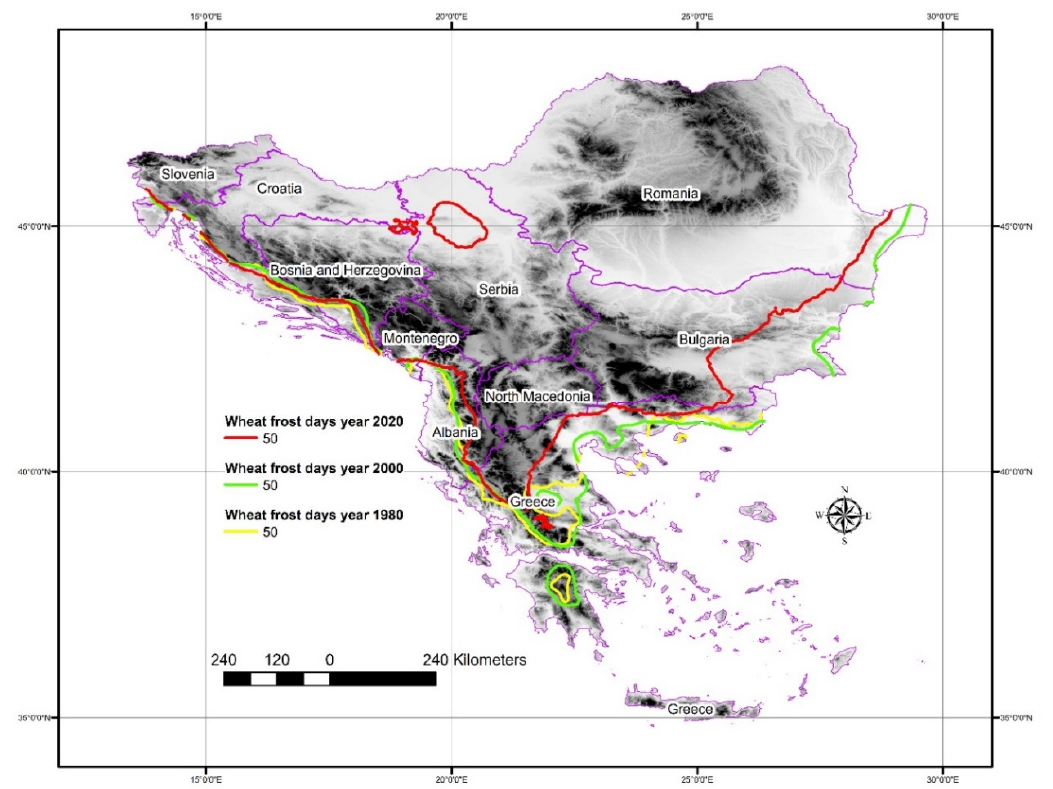
Figure 13. The spatiotemporal variation of the isolines of the 50 frost days for the wheat cultivation (for the years 1980, 2000, 2020).